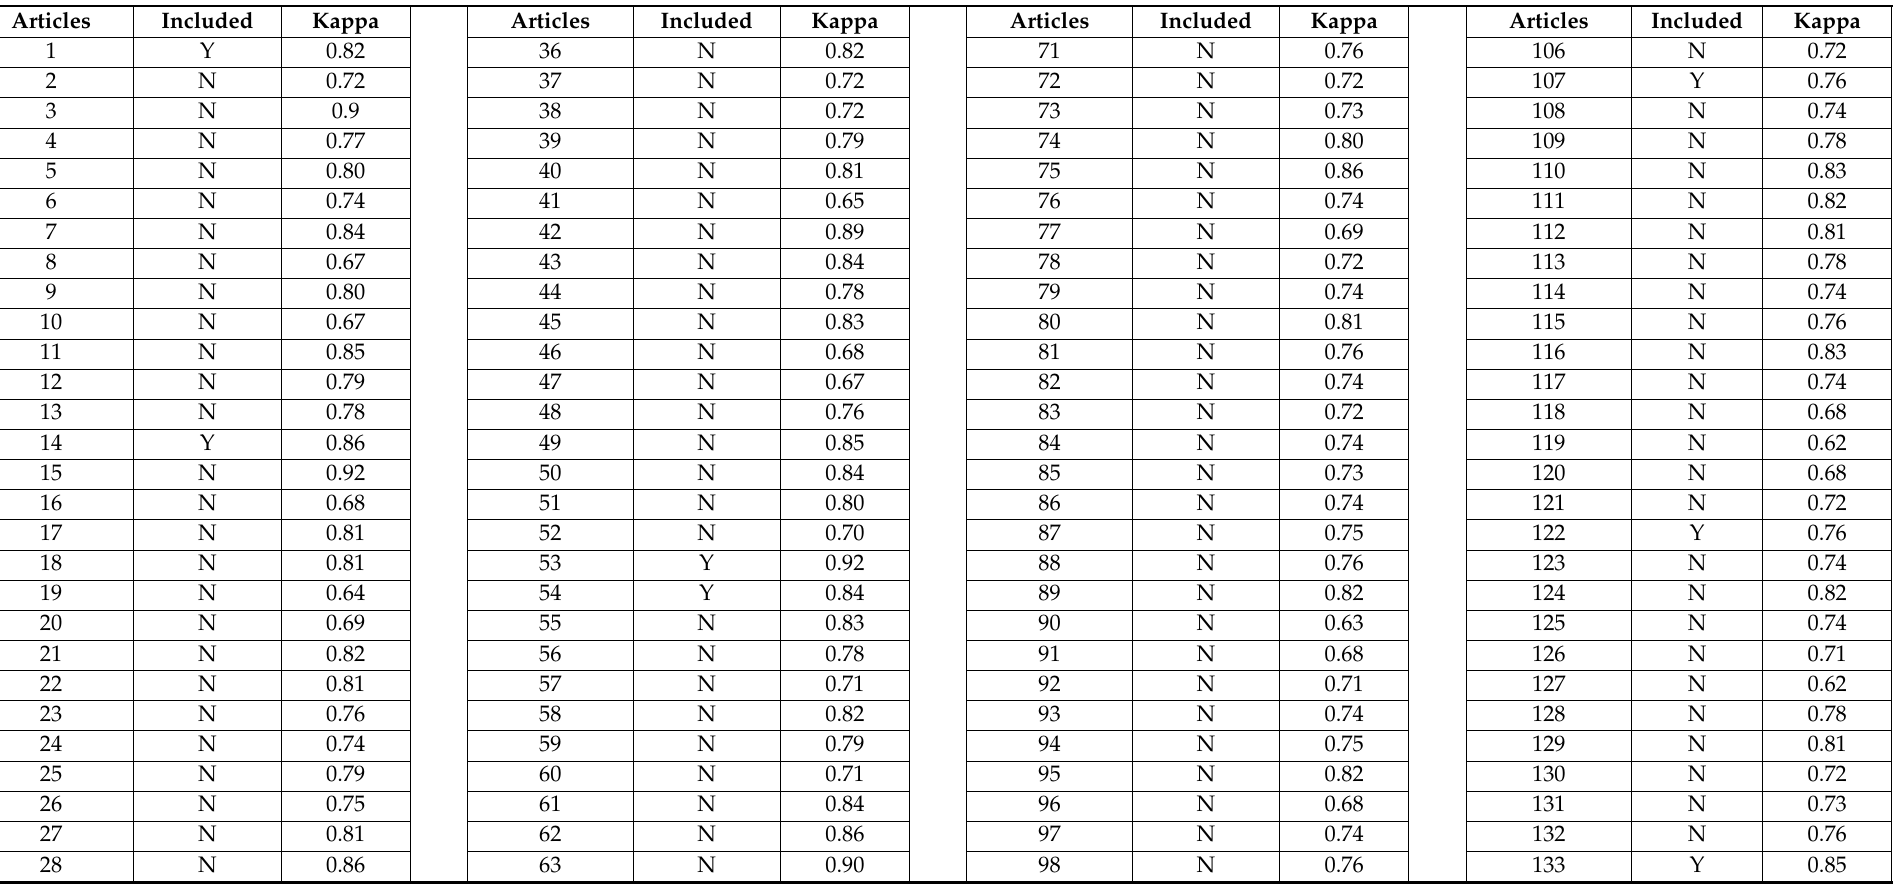
Table 1. The data of kappa agreement during the selection and extraction of data from the